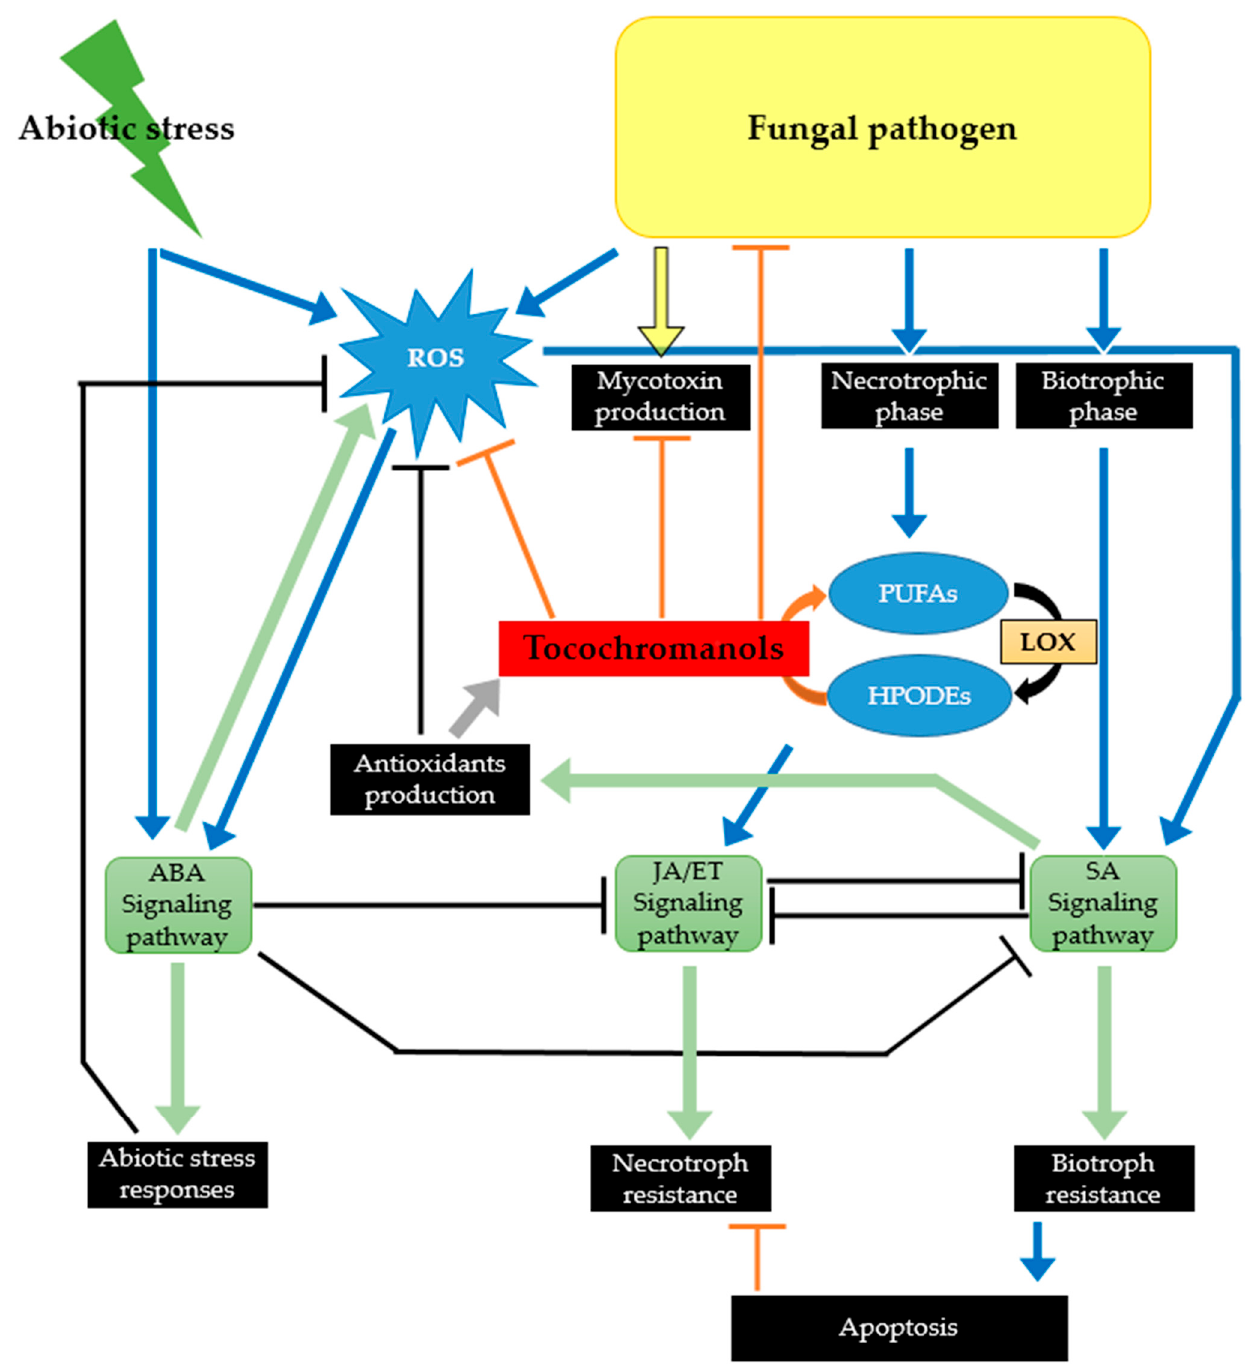
Figure 4. Involvement of tocochromanols in plant response to biotic and abiotic stresses. ROS: reac- tive oxygen species; PUFAs: polyunsaturated fatty acids; HPODEs: hydroperoxides; LOX: lipoxy- genase; ABA: abscisic acid; JA: jasmonic acid; ET: ethylene; SA: salicylic acid.